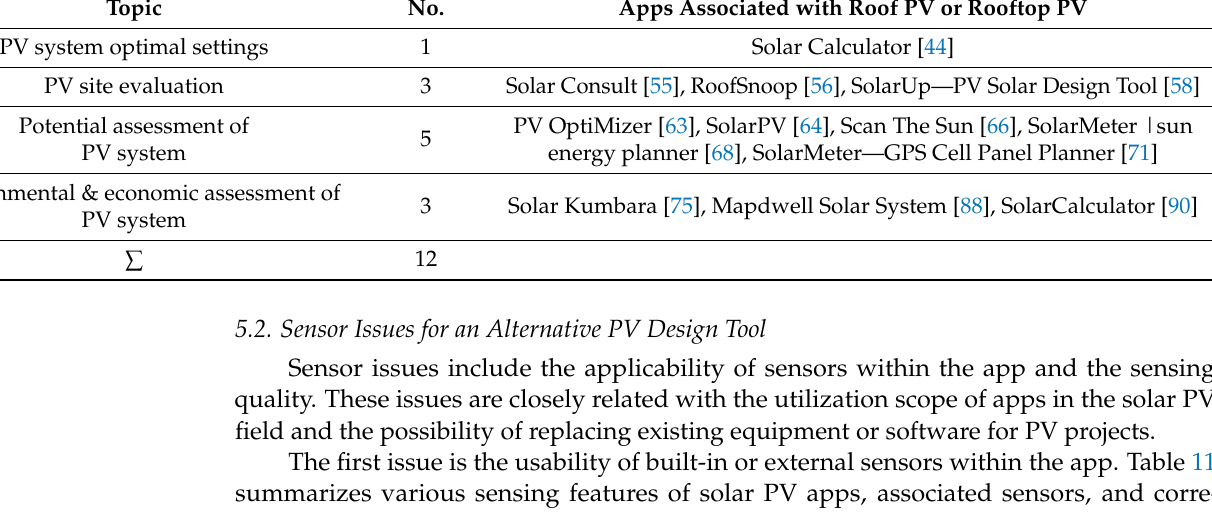
Table 10. Summary of smartphone applications for education and learning purposes of PV system. Topic No. Apps Associated with Roof PV or Rooftop